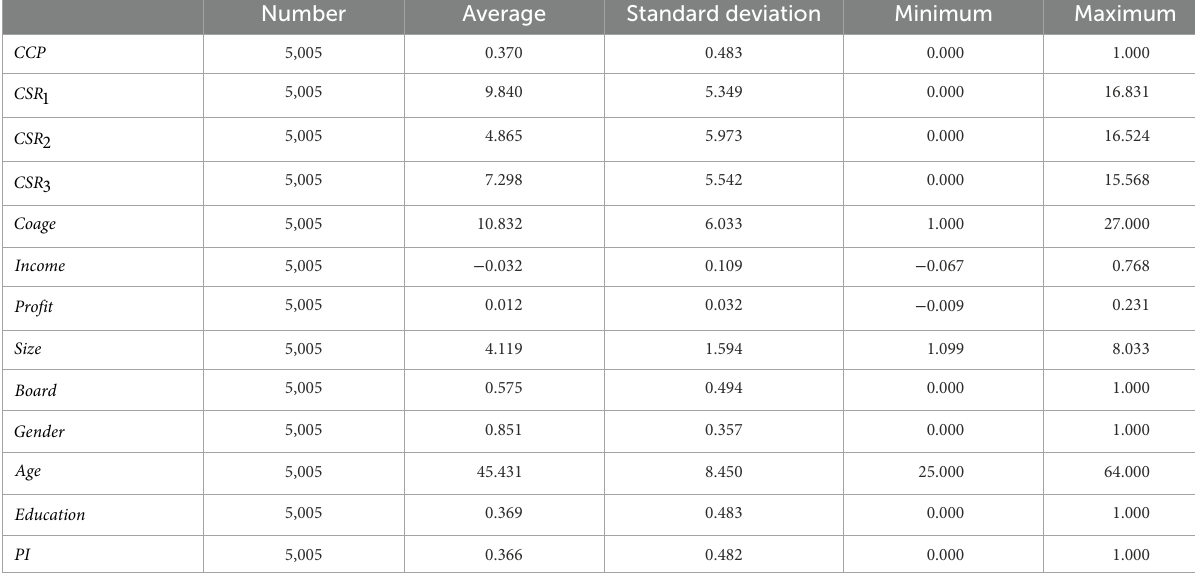
TABLE 2 Descriptive statistics of the variables. Number